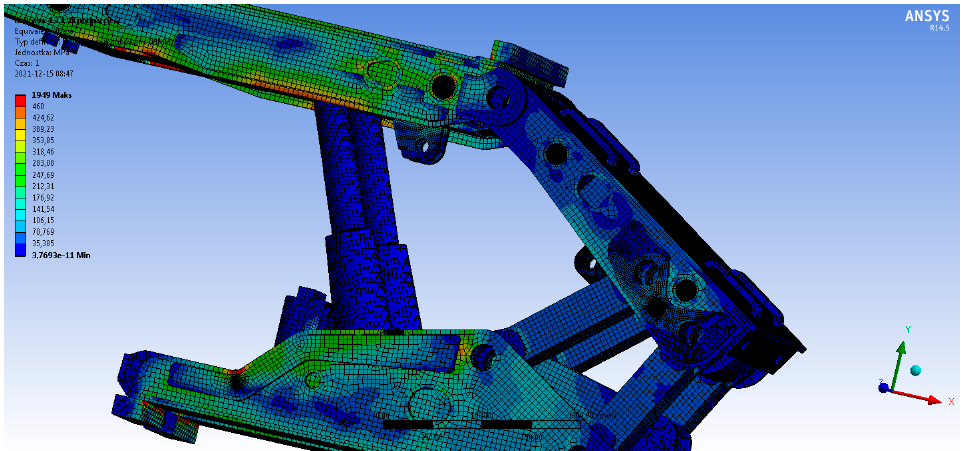
Figure 8. Stress analysis on a finite element grid—support’s